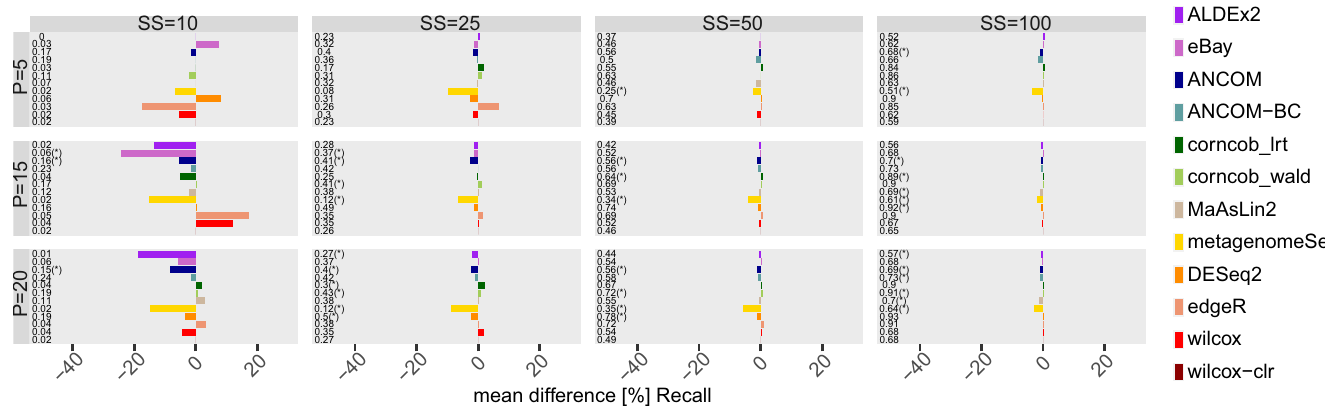
Fig 11. Mean Recall difference [%] between each differential abundance method and its GMPR normalised version for tooth dataset in the scenario with simulated DA features. Different percentages (P) of simulated DA features are on rows, while different sample size (SS) values are on columns. Numbers at the beginning of each row correspond to the Recall values obtained with default normalization, while the symbol ( � ) identifies that the Wilcoxon paired statistical test is significant.